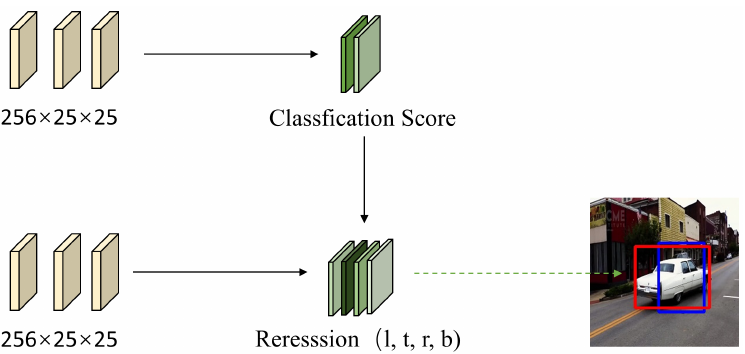
Figure 2. The flow chart of the tracing head during inference. The blue bounding box has a higher classification score than the red bounding box, but the red bounding box has significantly more accurate tracking